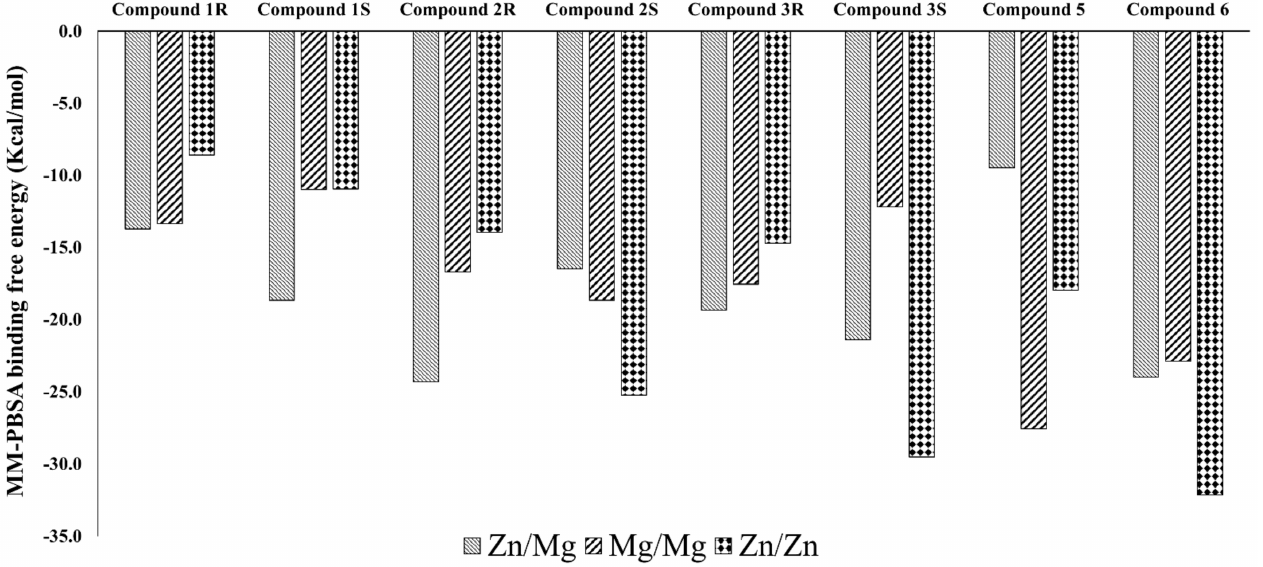
Figure 13. MM-PBSA binding free energy was calculated for the compounds in different metal